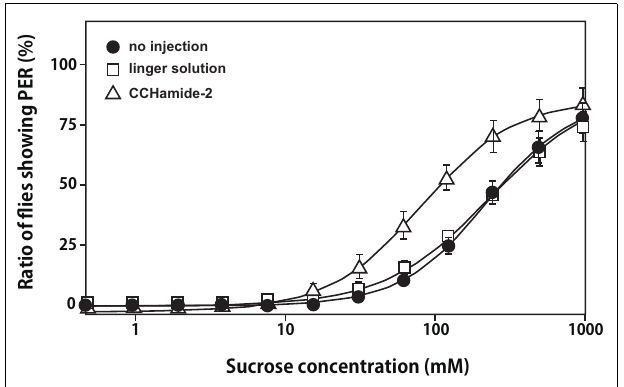
FIGURE 4 | Effect of CCHamide-2 on PER of the blowfly. Sigmoidal curves show the sucrose concentration–PER relationship for three fly groups: no injection (closed circle), injection with linger solution (open square), and injection of CCHamide-2 (open triangle). Each symbol on the line graph represents the mean ± SEM of data from five replicates for each